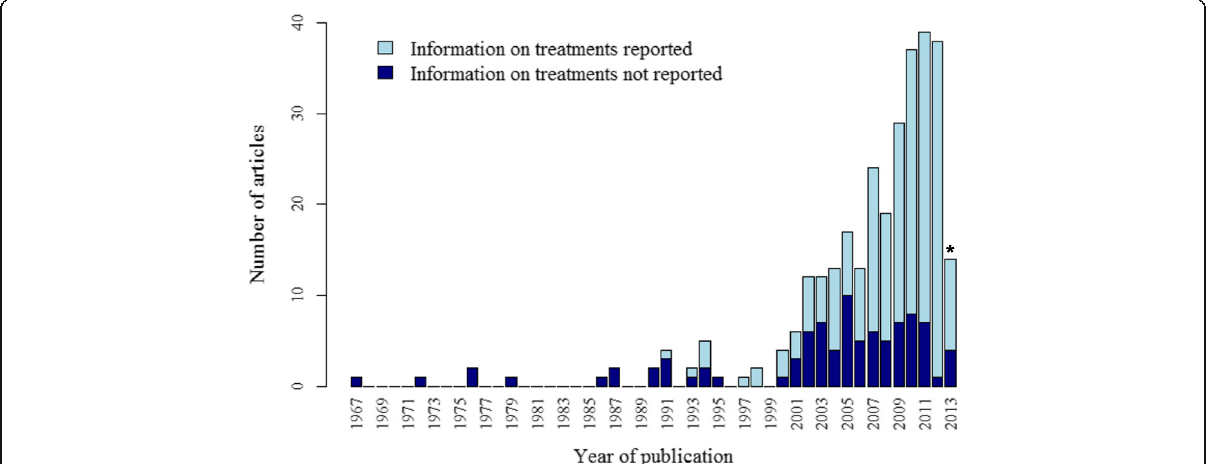
Fig. 3 Reporting of treatment in CVD prognostic modelling studies over time. Articles were classified as having reported information on treatment if the use of at least one potentially risk-lowering treatment in the study was reported, or if the effect of a treatment on the study findings was discussed. (*) Articles were included up to June 2013; this column only represents treatment reporting during the first half of 2013